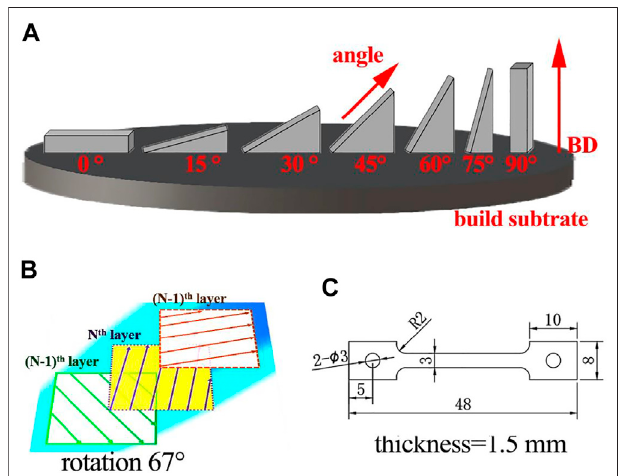
FIGURE 1 | Model design: (A) 45 ° sample, (B) 75 ° sample, (C) selected laser scanning strategy, and (D) dimensions (in mm) used in the fabrication of the tensile